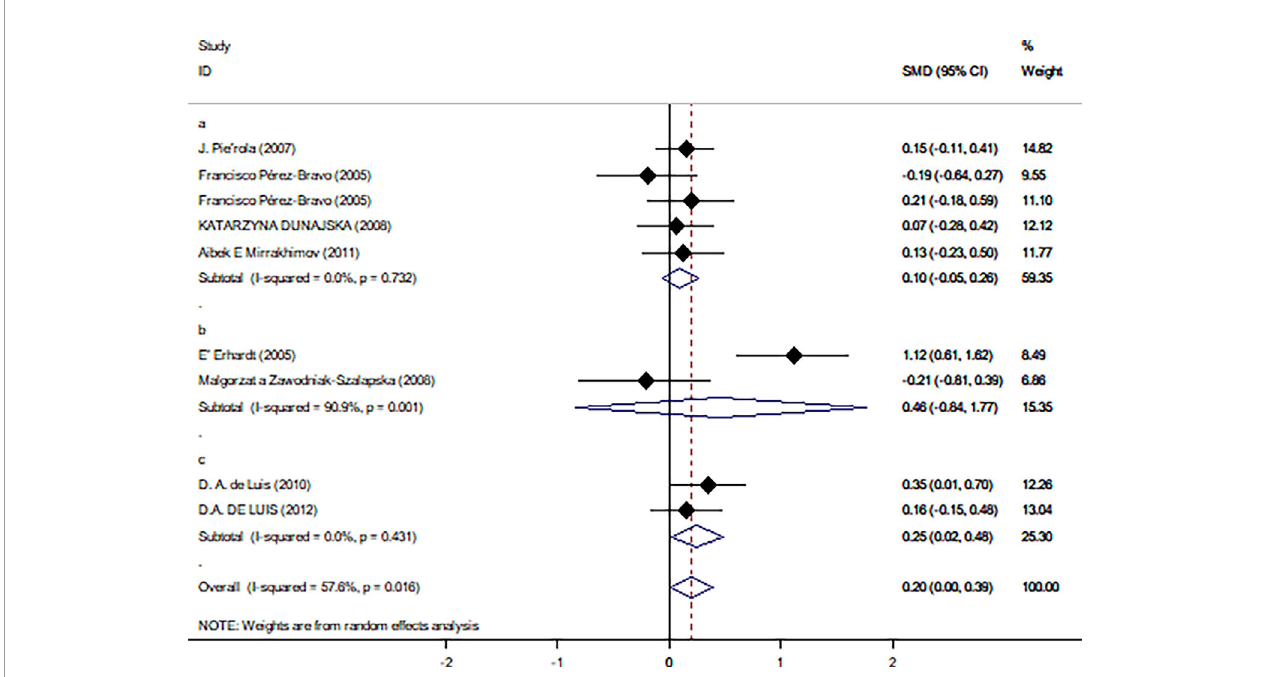
FIGURE 4 | Forest plot of correlations between Trp64Arg mutation and insulin resistance-based onset status. 95% con fi dence intervals ( CI ) are expressed in bars (each group) and diamond (all studies). Summary estimates were analyzed using a random-effects model. Pierola et al., Pe ́ rez-Bravo et al., Dunajska et al., and Mirrakhimov et al. presented data from people with fasting test status; Erhardt et al. and Zawodniak-Szalapska et al. presented data from people with 75-g OGTT test status. de Luis et al. presented data from people with normal test status. SMD, standardized mean difference; OGTT, oral glucose tolerance test.